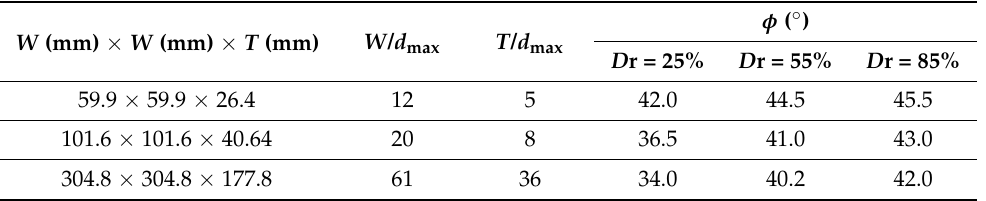
Table 4. Friction angles of gravel having a d max value of 5 mm with different relative densities ( D r ), obtained by direct shear tests with three shear box sizes